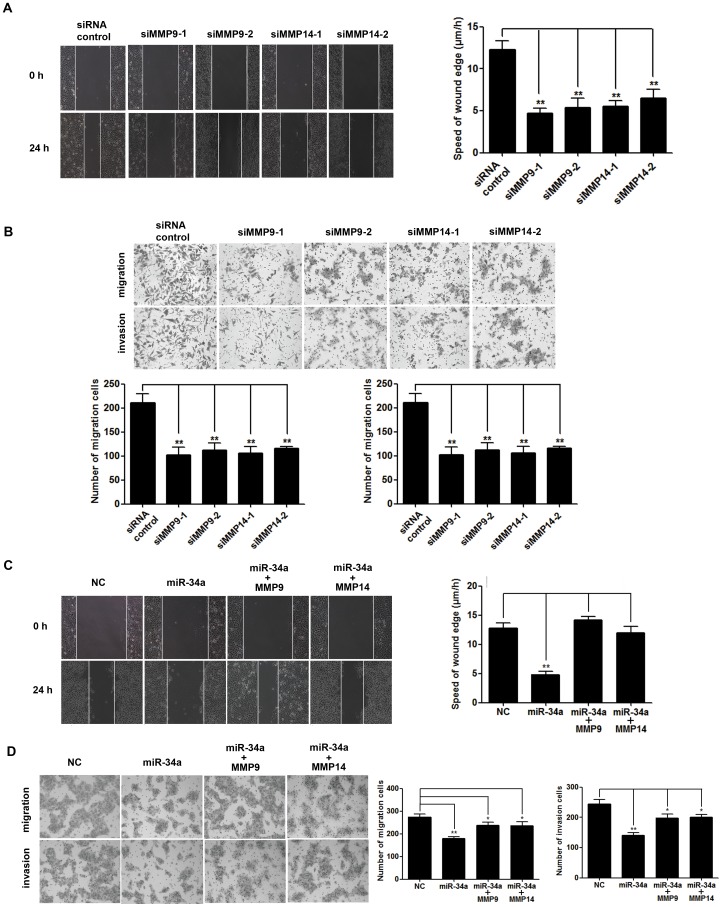
Inhibition of MMP9 and MMP14 was responsible for the TSCC cells migration and invasion effects of miR-34a.(A) and (B), Inhibition of cell migration and invasion by knockdown of MMP9 and MMP14. CAL27 cells were transfected with siRNA control, siMMP9-1, siMMP9-2, siMMP14-1, and siMMP14-2 as indicated. (C) and (D), MMP9 and MMP14 overexpression partially rescues miR-34a-reduced cell migration and invasion. Representative photomicrographs of wound healing and transwell assays results for stable expression miR-34a CAL27 cells transfected with pcDNA3.0-MMP9 (MMP9) or pcDNA3.0-MMP14 (MMP14) (×200 magnification, **
P<0.01).